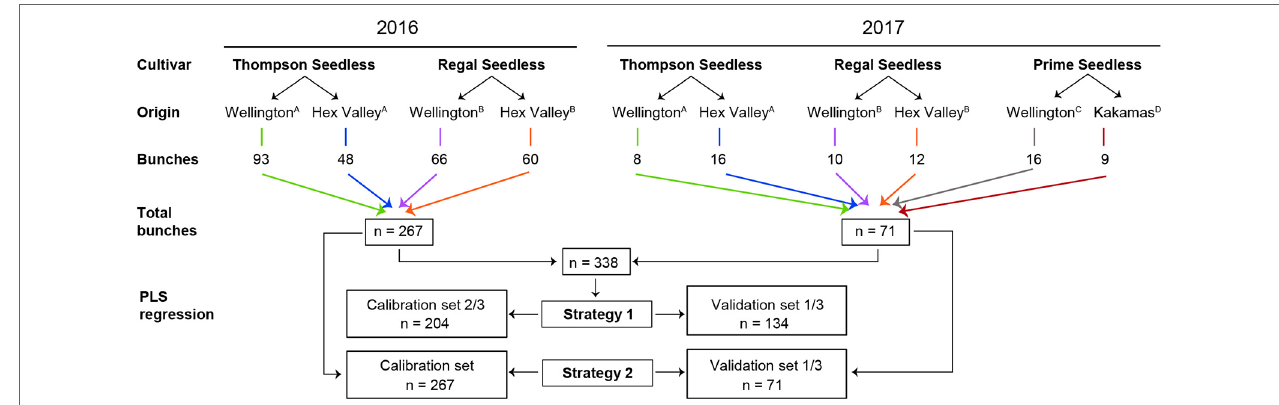
FIGURe 1 | Experimental design for the 338 intact table grape bunches subjected to Fourier transform near-infrared (FT-NIR) spectroscopy. A Grapes harvested from the same vineyard block in both years; B Grapes harvested from the same vineyard block in both years; and then C,D Grapes harvested from these two new vineyards blocks in 2017.